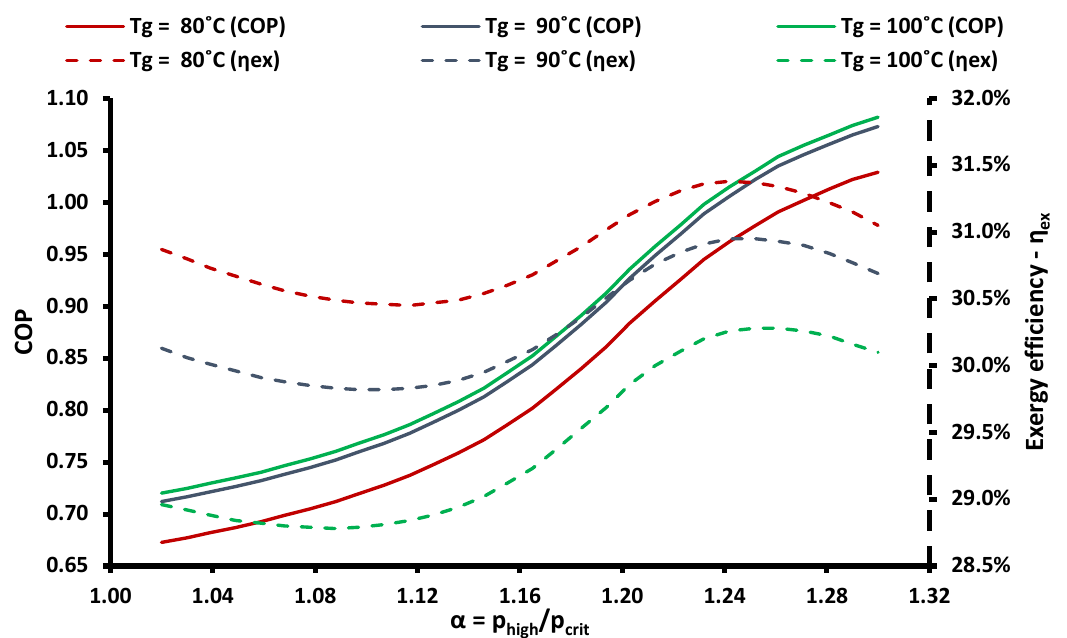
Figure 14. COP and exergy efficiency of the absorption chiller subcooling system for different pressure ratio parameters and generator temperature levels with (T e,ach = 10 °C, T e = − 15 °C, and T c = 40 °C).